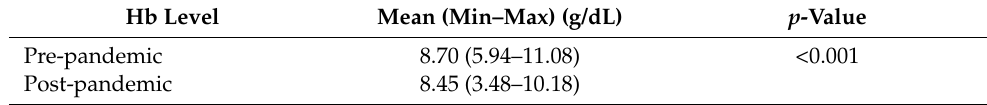
Table 3. Analysis of change of pre-transfusion hemoglobin level before and during pandemic.